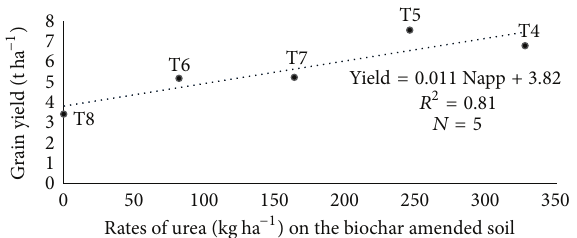
Figure 1: Linear relationship between levels of nitrogen applied on a soil amended with biochar and grain yield.